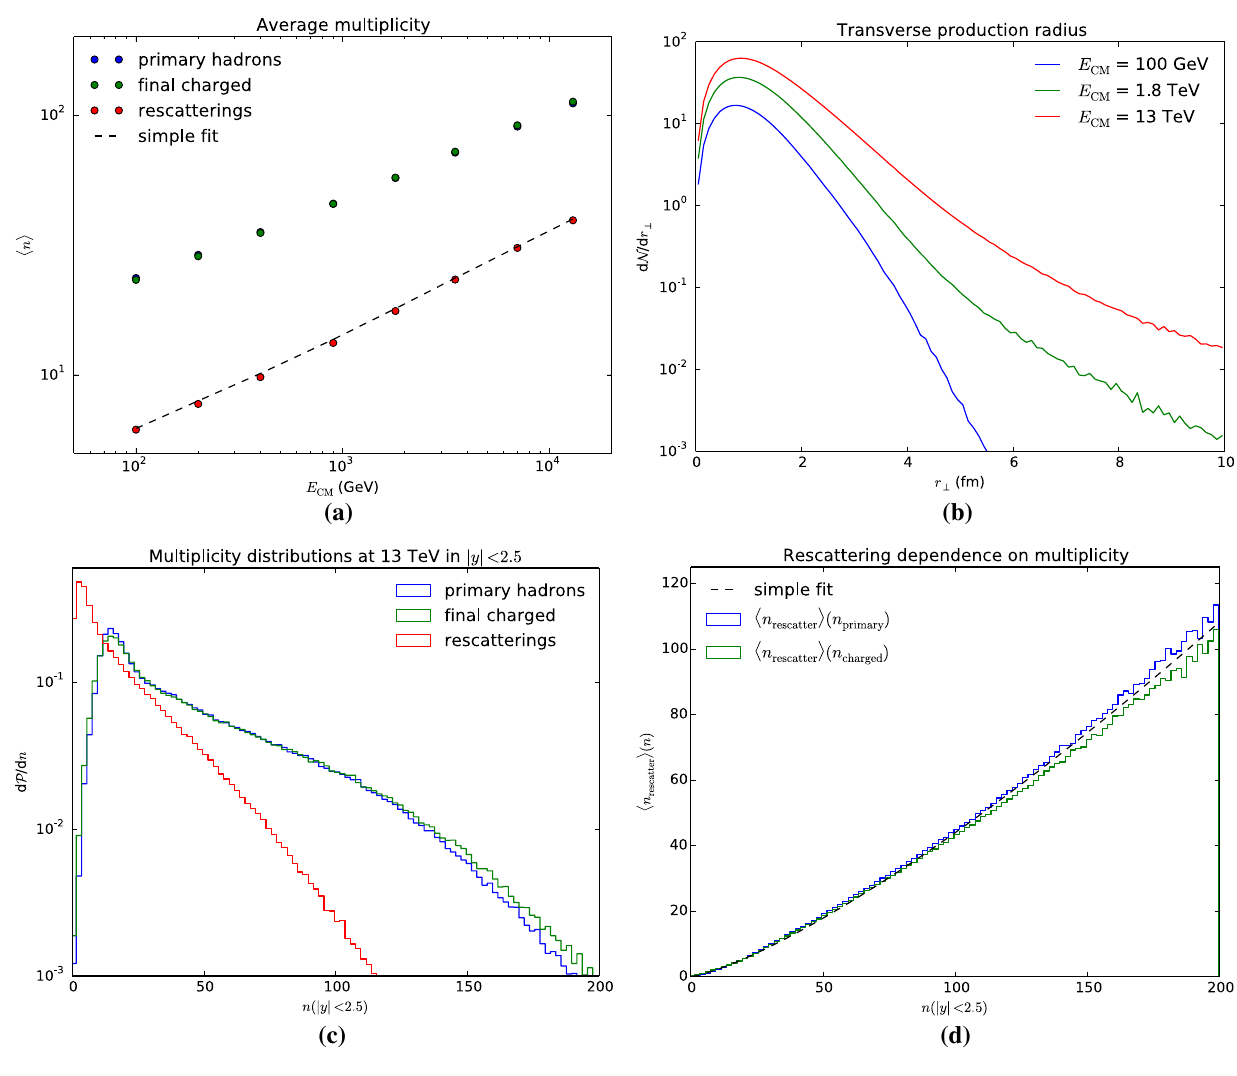
Fig. 12 a Energy dependence of multiplicities in nondiffractive pp collisions. b Primary hadron production in r ⊥ = energies. c Distribution in the numbers of primary hadrons, charged